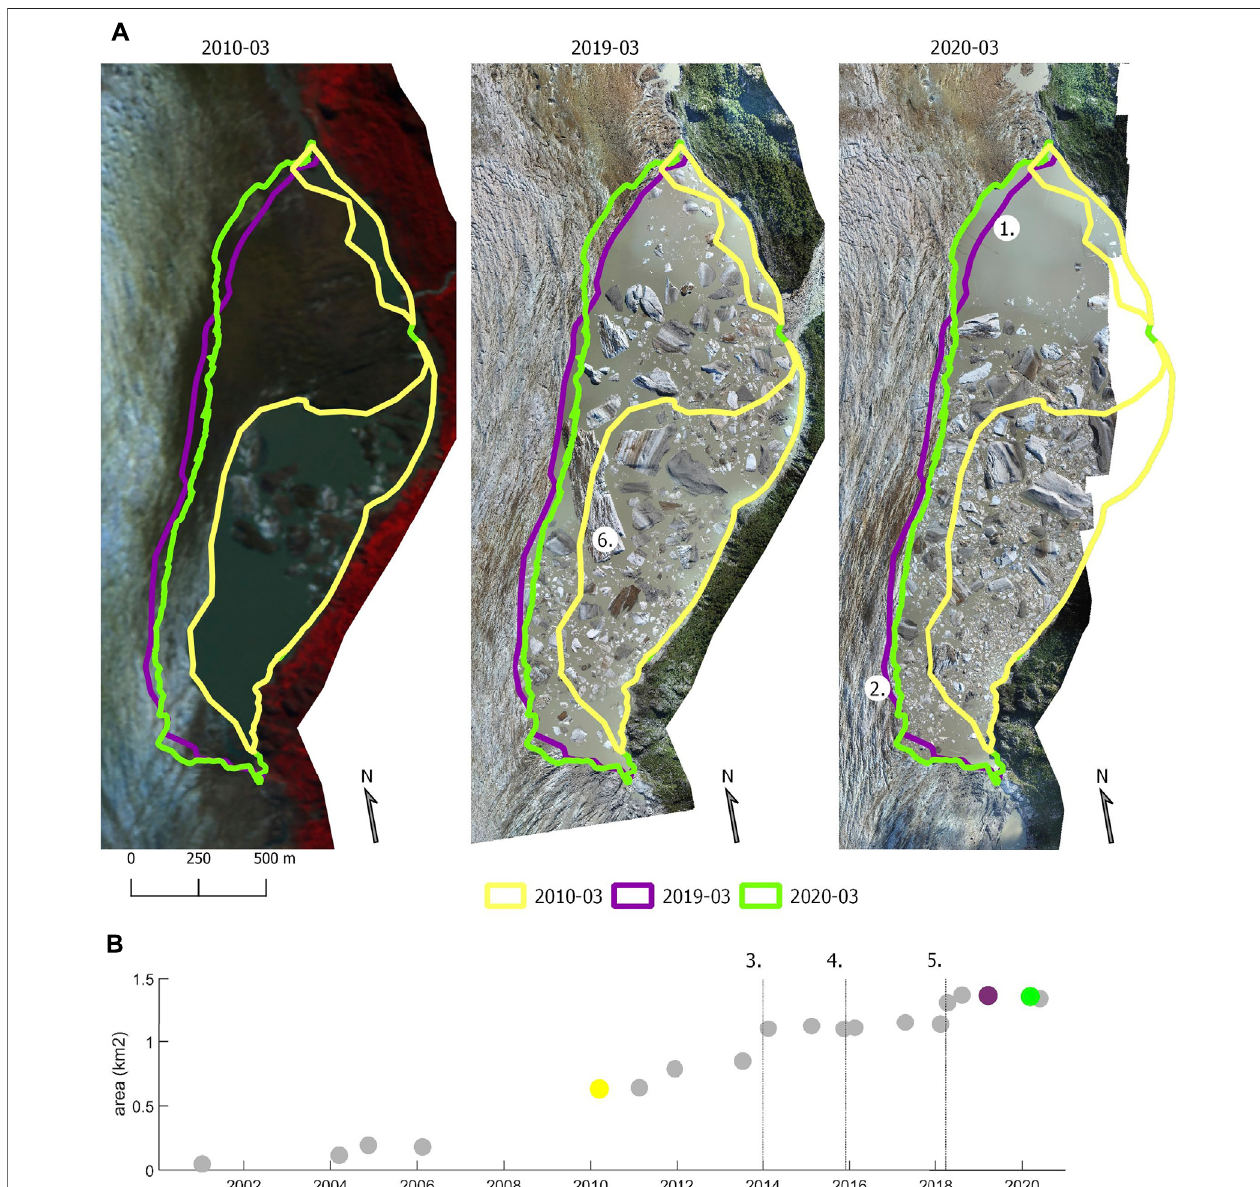
area larger than 0.5 km 2 and expanded steadily until 2014, reaching an area of 1.1 km 2 (see (3.) in Figure 5B ). Note that the date of GLOF from Chileno Valley is marked with (4.) in Figure 5B . Since 2014, the east marginal lake maintained this extent until April 2018 where it expanded ~0.3 km 2 (see (5.) in Figure 5B ). The sudden expansion of the lake in 2018 matches with GLOF date from Triángulo Lake located at tributary Bayo Glacier (Bañales-Seguel et al., 2020). Lastly, UAVs images show that in March 2019 the area corresponded to 1.405 km 2 and in March 2020 the area decreased to 1.397 km 2 . The UAV images show that the lake expanded by calving to the north (see (1.)